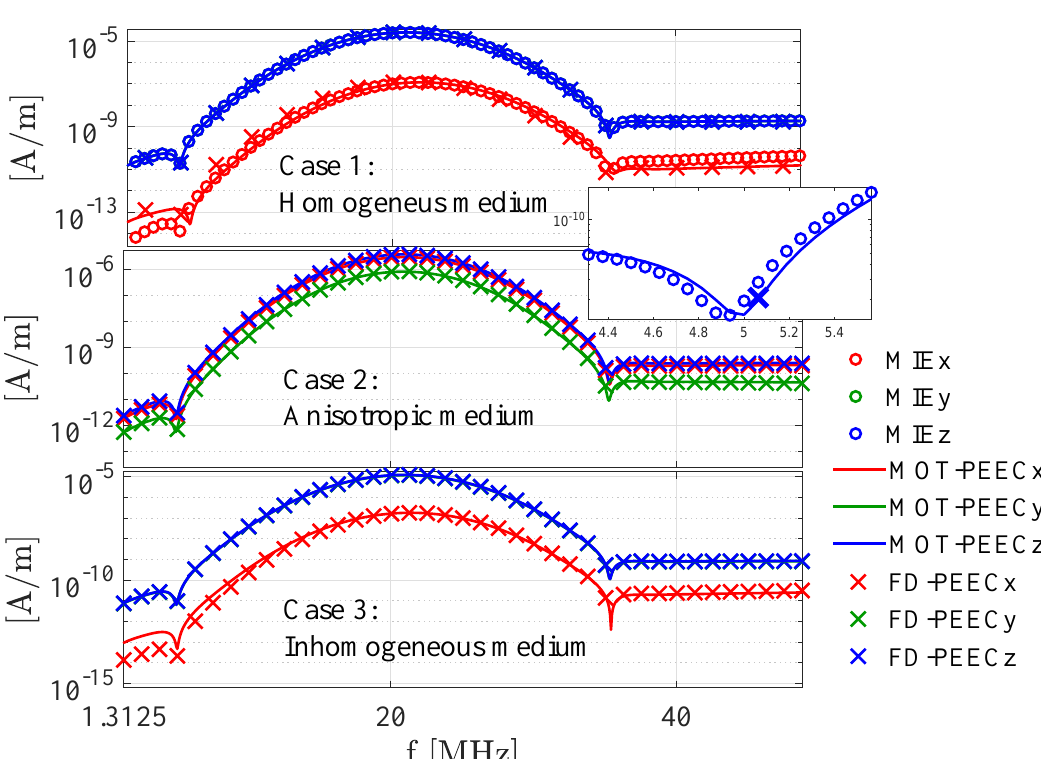
Figure 5. Frequency spectra of | H x | , | H y | , and | H z | evaluated in the target point [ 5 m,5 m,5 m ] —Cases 1, 2, and